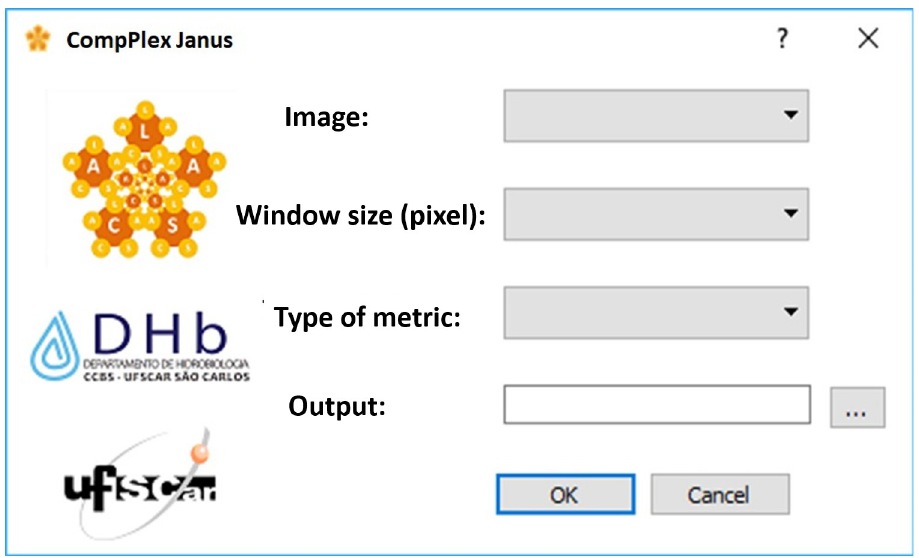
Fig 5. CompPlex Janus toolbox interface.